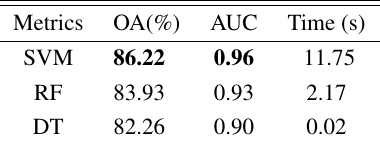
Table 2. Classification of components using different classifiers